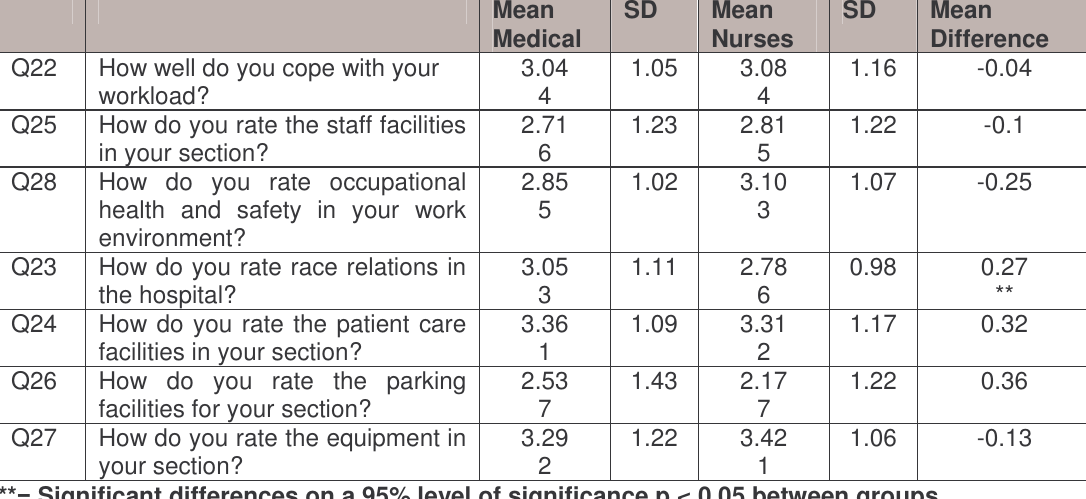
Table 4: Operational functions (Average mean 2.96)